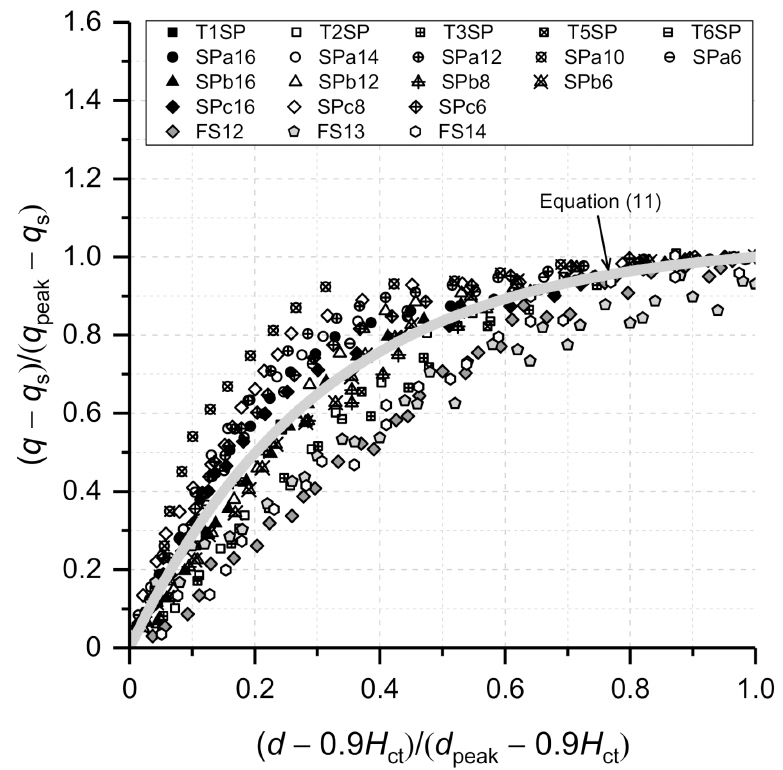
Figure 7. Comparison of measured and predicted penetration resistance profiles between d = 0.9 H ct and d peak